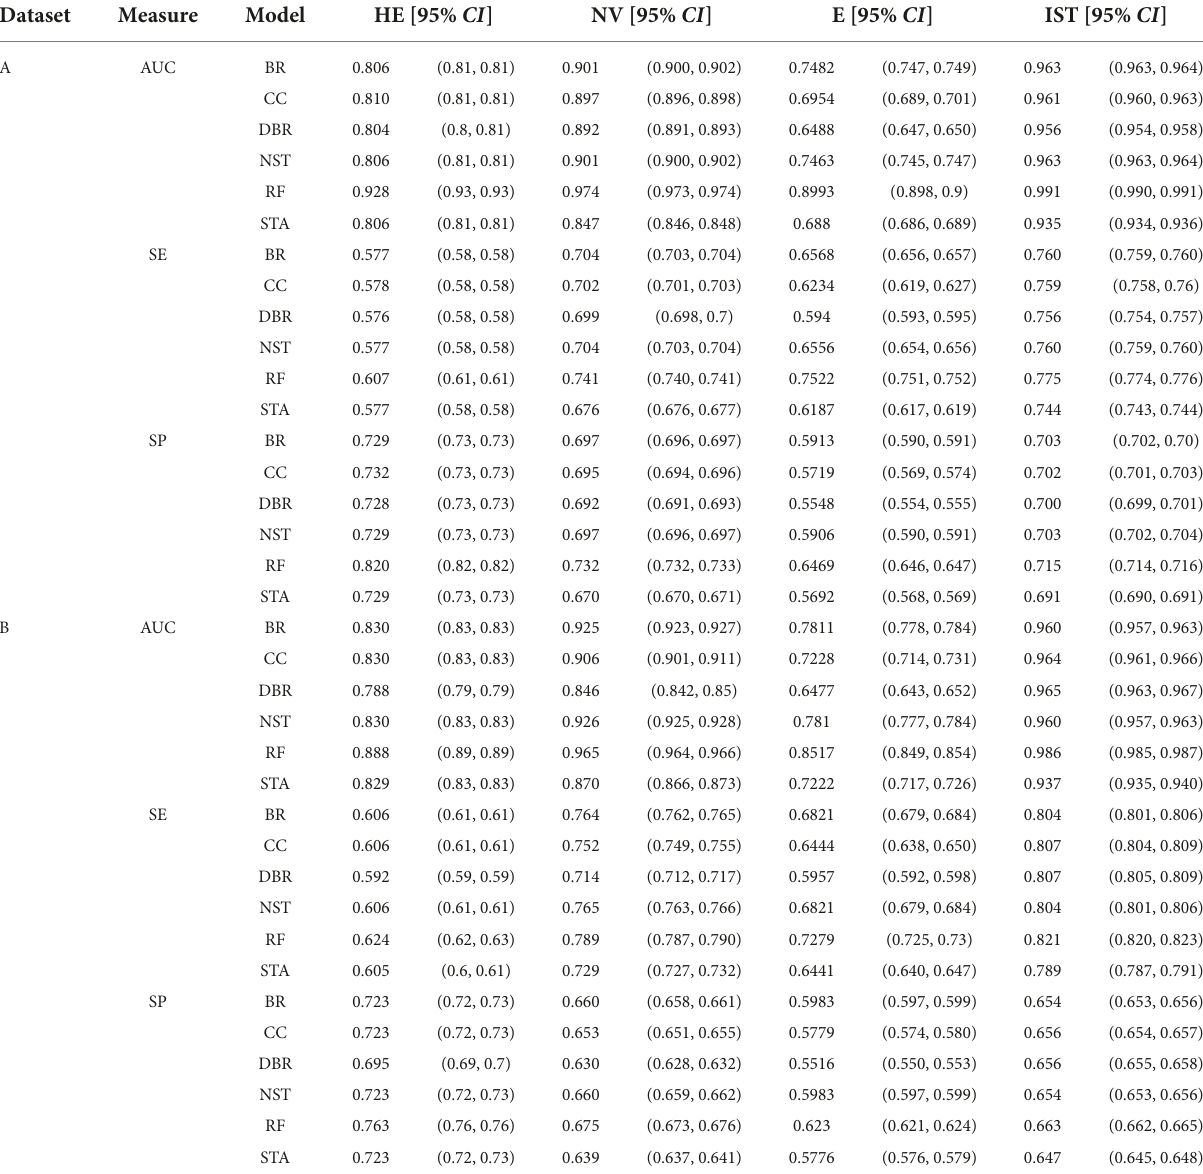
TABLE 2 The area under the curve (AUC), sensitivity, and specificity [95% CI ] values of six machine learning classifiers based on degenerative findings in datasets A and